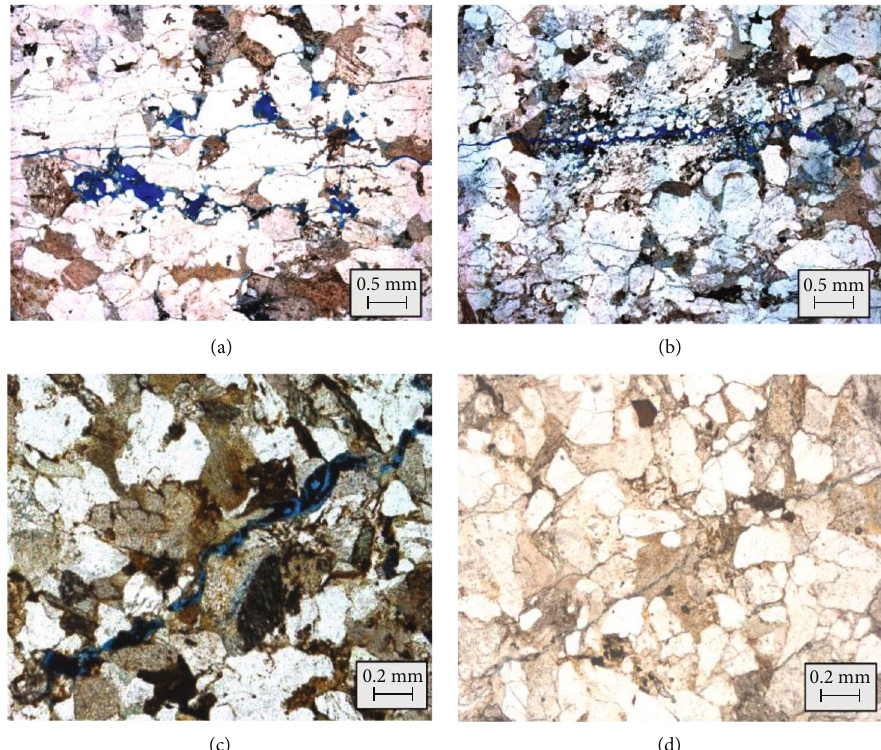
Figure 8: Typical fractures in thin section. (a) Well DB105, 4764.18m; the formation of Jurassic, coarse-grained lithic sandstone; un fi lled microfractures are distributed in parallel layers, and intergranular pores and intragranular dissolved pores are connected with the fractures. (b) Well DB105, 4770.19m; Ahe formation of Jurassic, under compaction and stress; the particles are in point line contact, and intragranular solution pores and microcracks are developed. The microcracks cut the particles intermittently and extend parallel to the plane with directionality. (c) Well X2, 5129.7m; the formation of Jurassic Medium sandstone, dense rock, poor pore performance; see a microfracture half fi lled with asphaltene; (d) YN5, 4561.7m; Yangxia formation of Jurassic, medium grained sandy structure, dense rock, poor pore performance, and developed